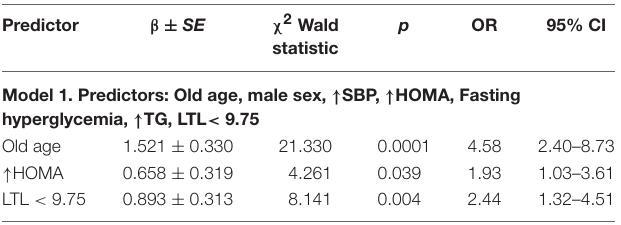
TABLE 7 | Results of logistic regression analysis in general group where c-f PWV > 10 m/s is dependent variable. Predictor β ± SE χ 2 Wald